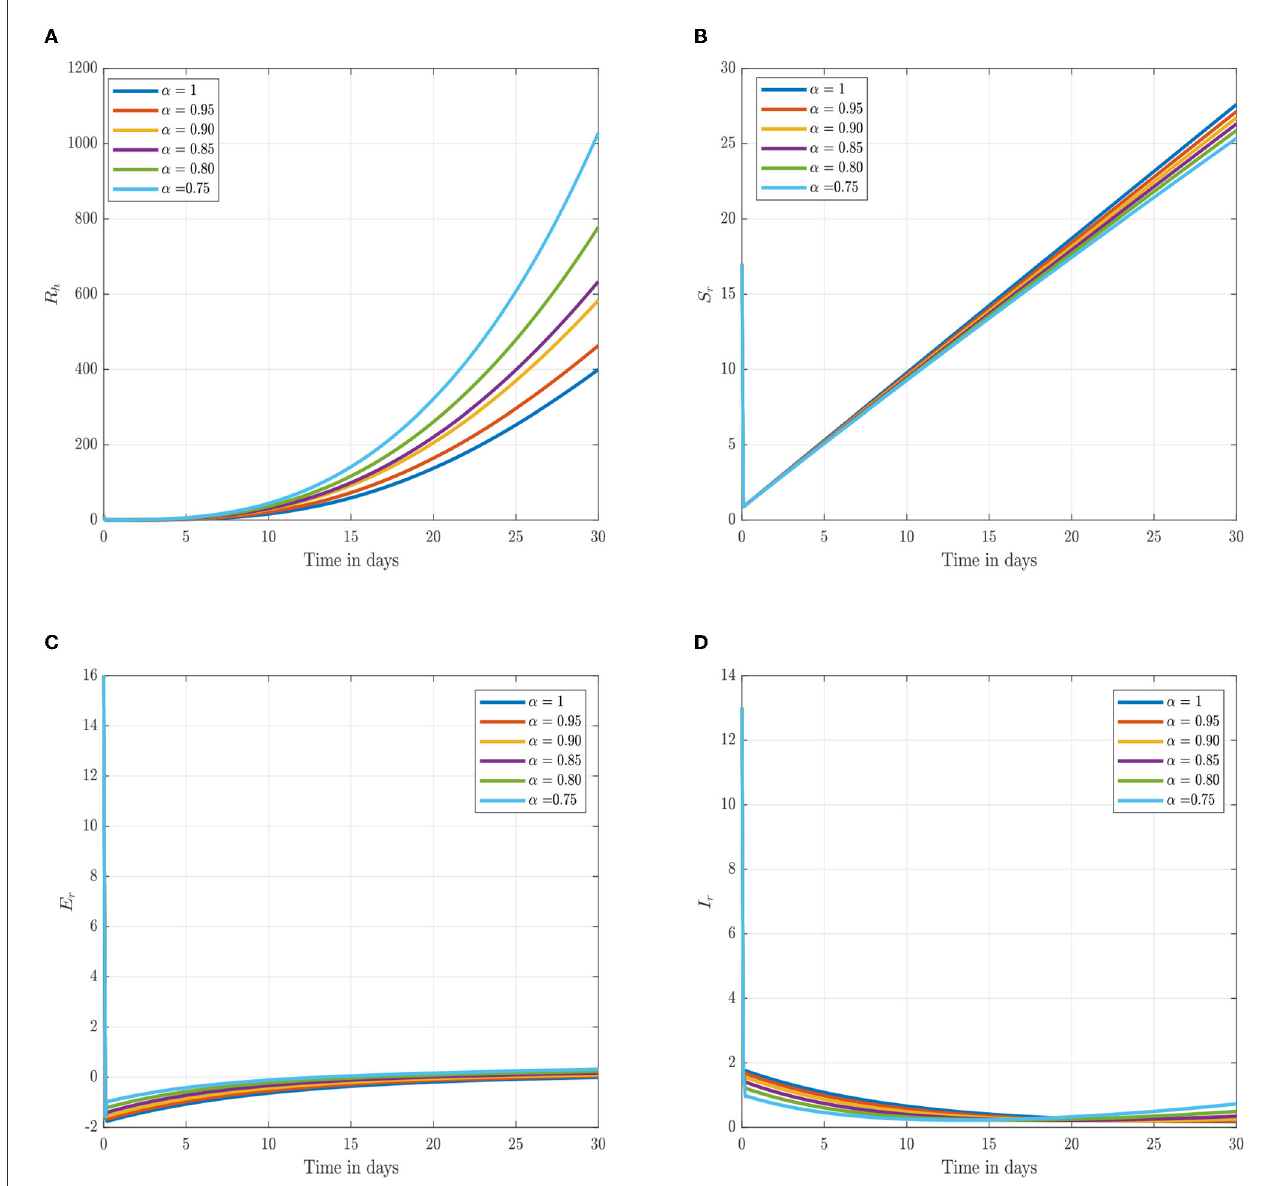
FIGURE5 Numerical trajectory of the CF-fractional-order derivative, α , of Equation (2). (A) Dynamics of recovery ( R h ) class. (B) Dynamics of susceptible ( S r ) rodents class. (C) Dynamics of exposed ( E r ) rodents class. (D) Dynamics of asymptomatic infected ( I r ) rodents